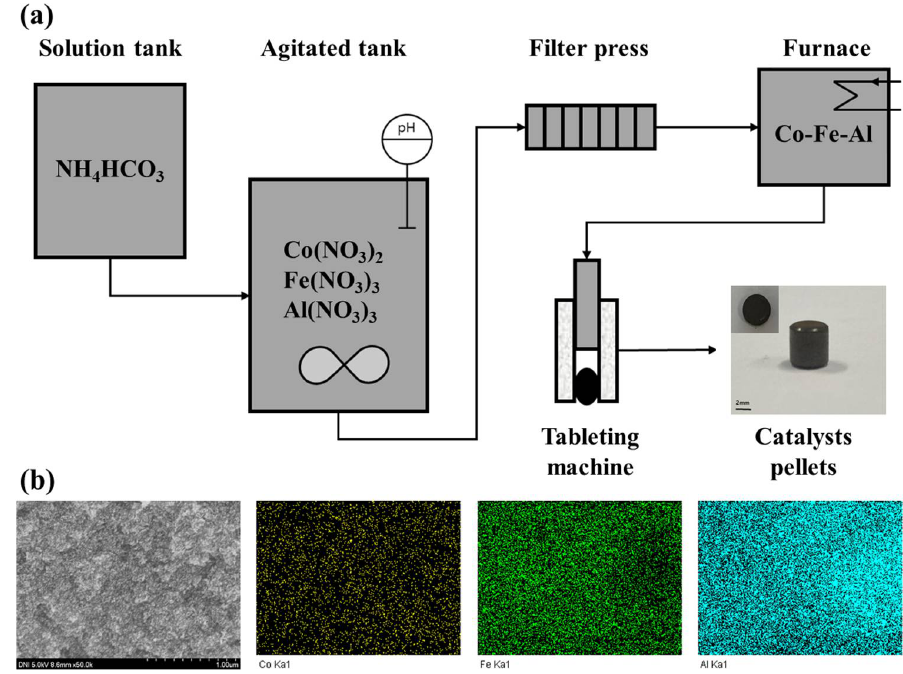
Figure 5. ( a ) Scheme of the pilot-scale synthesis and ( b ) SEM image and SEM–EDS.